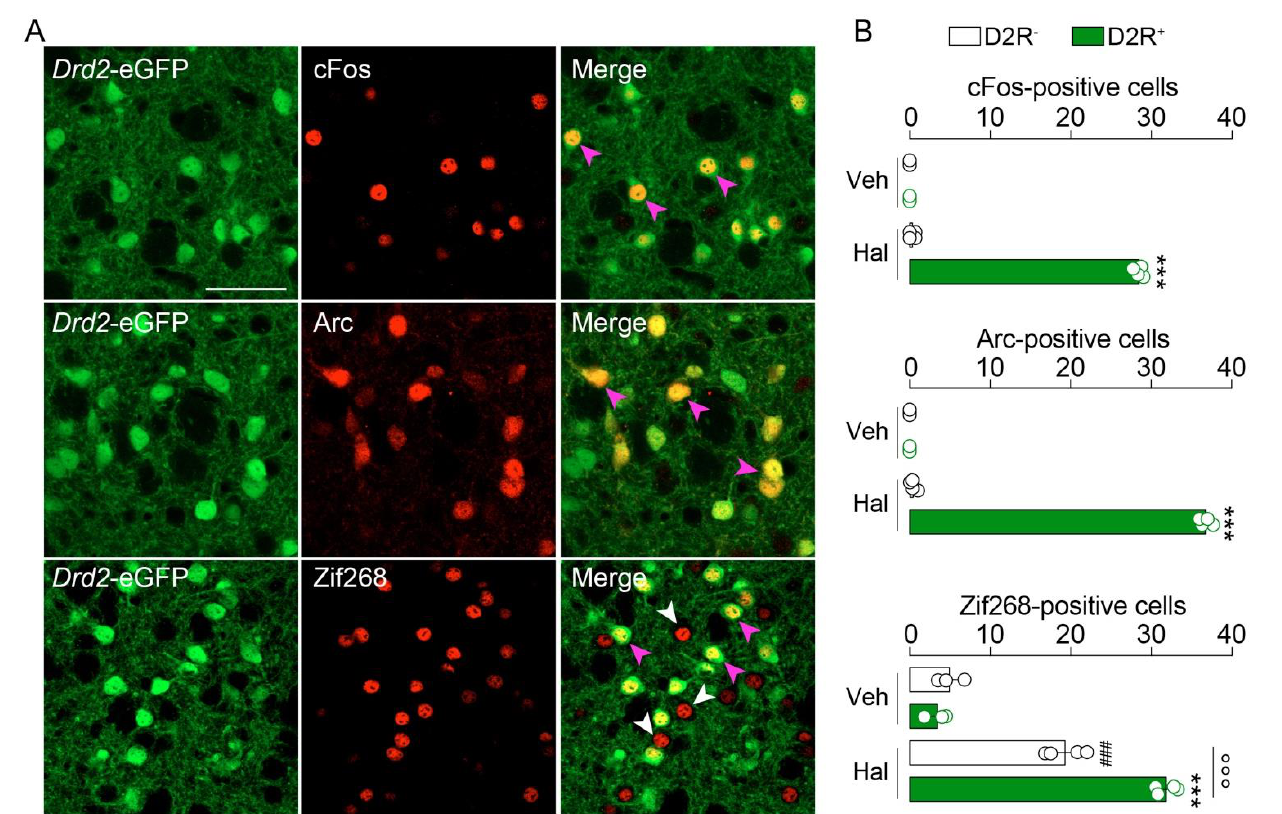
Figure 1. Haloperidol induces cFos, Arc and Zif268 in a cell type-specific manner in the mouse striatum. ( A ) Double immunofluorescence detection of cFos, Arc and Zif268 in the striatum of Drd2 -eGFP mice 60 min after vehicle (Veh) or haloperidol (Hal) administration. Arrows in magenta indicate the expression of immediate early genes (IEGs) in D2R + -neurons, whereas arrows in white indicate the expression of IEGs in D2R - - neurons. Scale bar: 50 μm. Note: given the low number of IEGs-positive neurons in Veh-treated mice, pictures are not shown. ( B ) Quantification of cFos, Arc and Zif268 in both D2R + - and D2R − -neurons. Statistics: *** p < 0.001 (Hal vs. Veh in D2R + -neurons), ### p < 0.001 (Hal vs. Veh in D2R − -neurons), °°° p < 0.001 (Hal in D2R + -neurons vs. Hal in D2R — neurons for Zif268). Veh ( n = 3) and Hal ( n = 4). One-way ANOVA: F (3, 10) = 5301, p < 0.0001 (cFos); F (3, 10) = 5618, p < 0.0001 (Arc); F (3, 10) = 180.7, p < 0.0001 (Zif268).